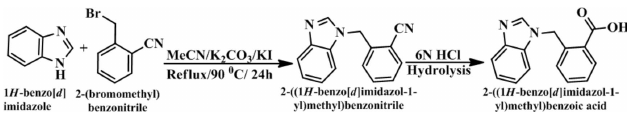
Figure 6 Reaction scheme.